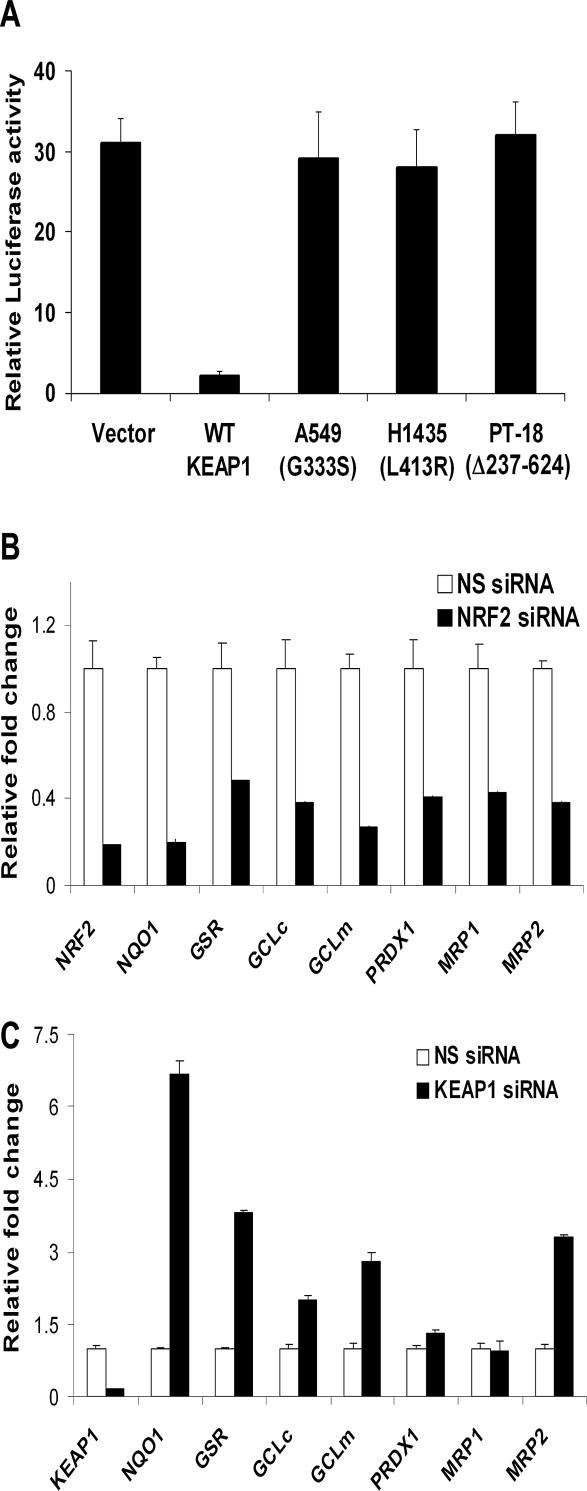
Mutant KEAP1 Protein Is Unable to Suppress NRF2 Activity(A) Repression activity of the KEAP1 mutants was monitored by a luciferase reporter assay. Wild-type and mutant KEAP1 cDNA constructs were transfected onto H838 cells stably expressing ARE luciferase reporter. Data represent mean ± SD (n = 3).(B) Silencing of NRF2 by siRNA in A549 cells downregulated the expression of NRF2-dependent genes. A nonspecific siRNA (NS siRNA) was used as control.(C) Inhibition of KEAP1 expression by siRNA in BEAS2B cells upregulated the expression of NRF2-dependent genes.